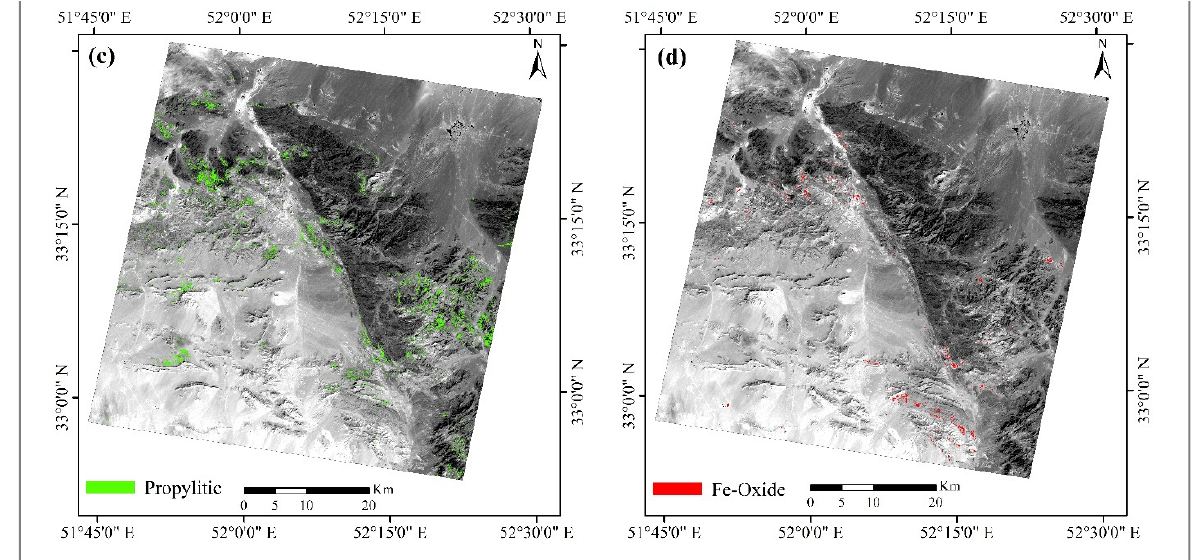
Figure 7. The results of SVM on the ASTER data. ( a ) Argillic alteration, ( b ) phyllic alteration, ( c ) propylitic alteration, and ( d ) Fe-oxide alteration.